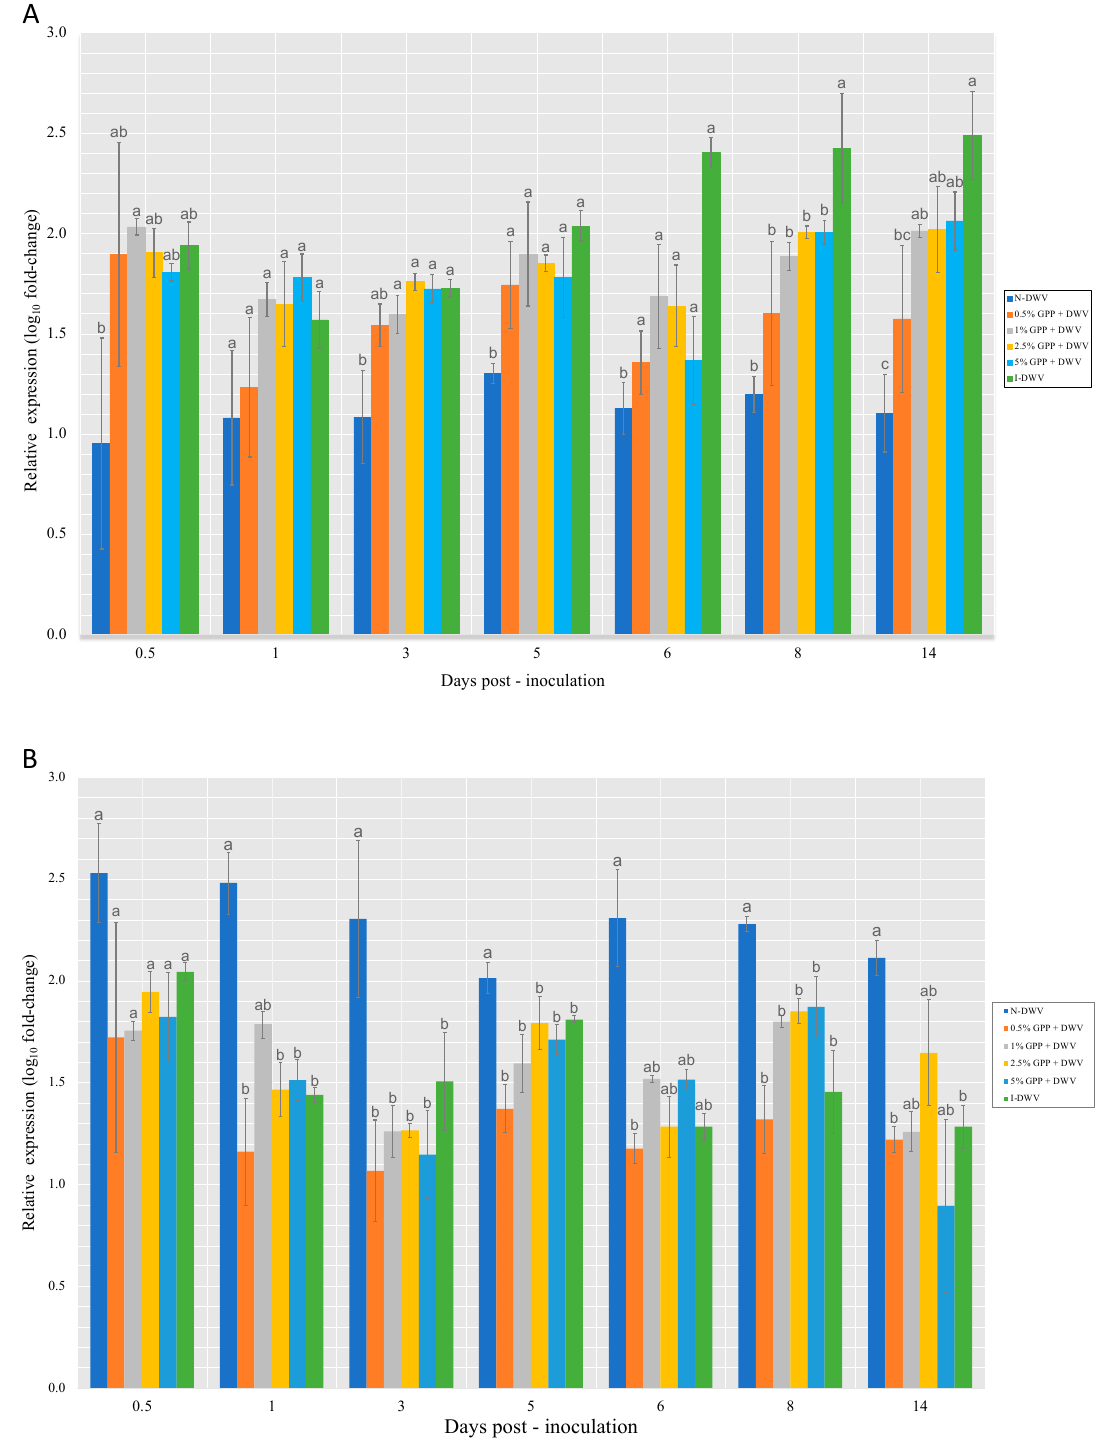
Figure 6. Expression level of Cactus ( A ) and Dorsal ( B ) genes involved in Toll pathway worker honeybees per collection throughout the assay. Grape pomace powder (GPP) concentrations (0.5, 1, 2.5 and 5%), inoculated control (I ‐ DWV), and non ‐ inoculated control (N ‐ DWV). Different letters indicate significant differences according to a Tukey’s test ( p < 0.005). All of the GPP treatments at different concentrations showed an intermediate expression with respect to N ‐ DWV and I ‐ DWV control treatments, with some exceptions.